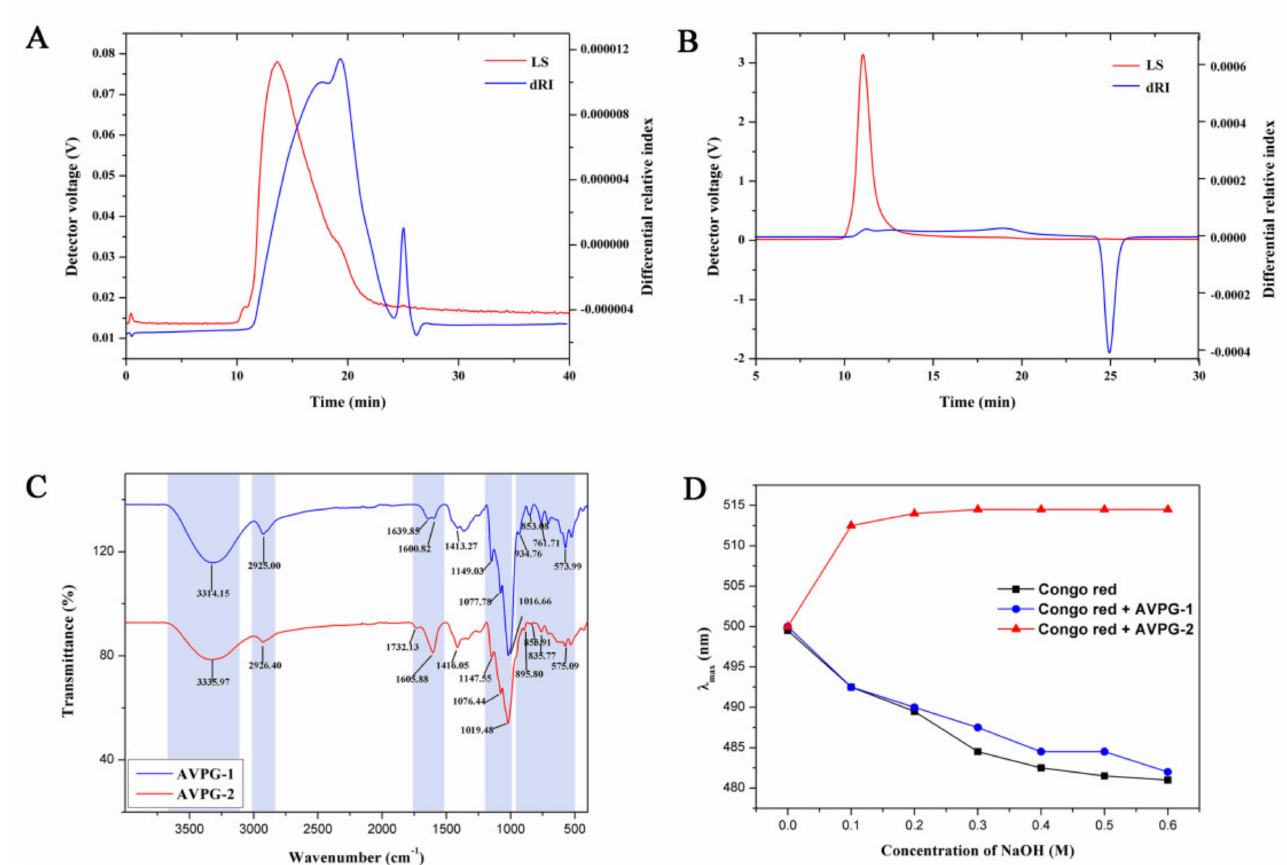
Figure 3. High performance size exclusion chromatography coupled with multi-angle laser light scattering and refractive index detector (HPSEC-MALLS-RID) chromatographic profile of the molar mass distribution of AVPG-1 ( A ) and AVPG-2 ( B ). Fourier transform infrared (FT-IR) spectroscopy of AVPG-1 and AVPG-2 ( C ). Maximum absorption wavelength of Congo red, Congo red + AVPG-1 or AVPG-2 at different concentrations of sodium hydroxide solution ( D